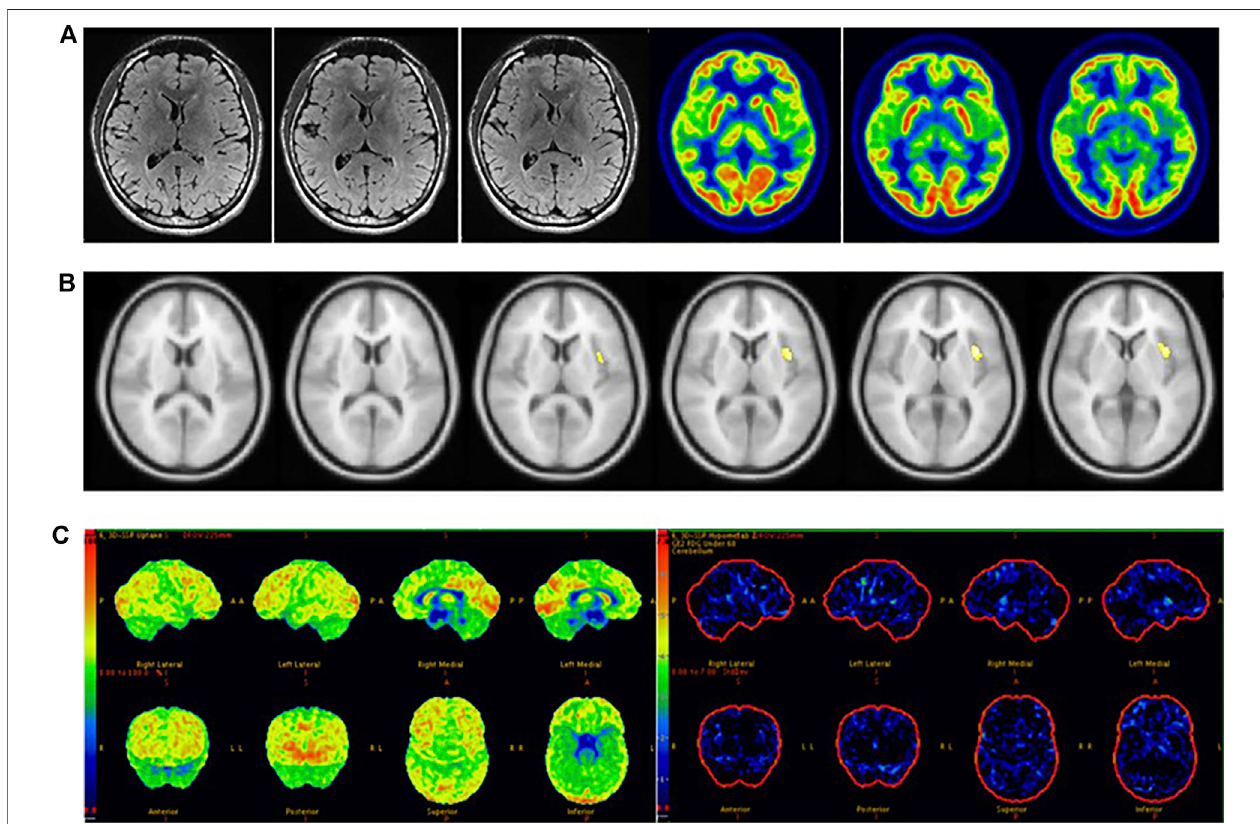
FIGURE 5 | Male, 22 years old, left insula epilepsy. (A) No structural lesions causing seizures were found at MRI 3.0 T epilepsy-protocol. 18 F-FDG PET showed doubtful abnormal decreased metabolism in the left insula lobe. (B) SPM did not fi nd abnormal metabolic regions whlie p < 0.005 and K > 200 but obtain abnormal metabolisminleftinsulawhile p < 0.005andK > 50. (C) 3D-SSPdidnotobtainabnormalmetabolicregions.Theleftinsulawassurgicallyresectedandlackofseizuresfor 2 years